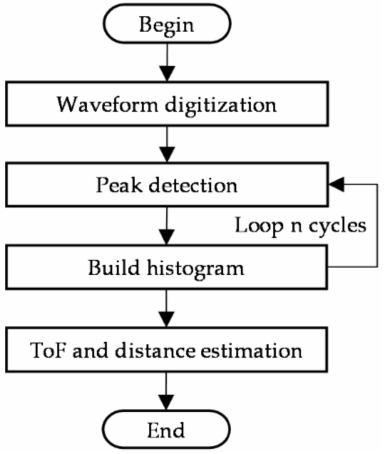
Figure 9. Procedure for determining ToF and distance by peak detection